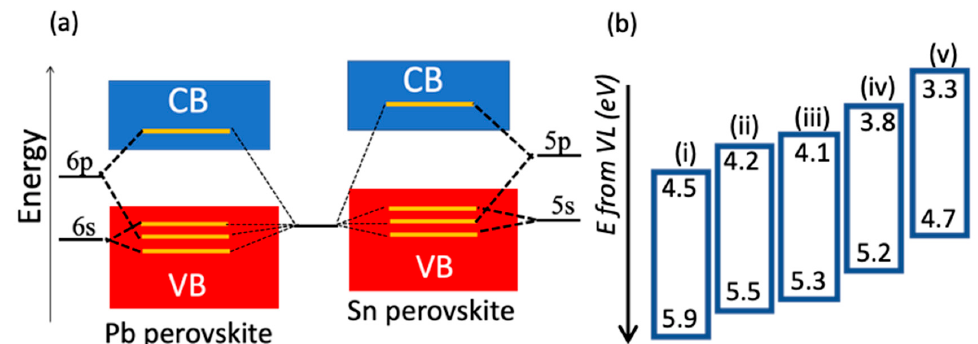
Figure 2. Energy of Sn perovskite bands compared to Pb perovskite and often observed discrepancy of measured and reported values of Sn perovskites’ properties, manifested in the bandgap, and the position of valence and conduction bands (VB and CB, respectively) with respect to vacuum level (VL). ( a ) Higher energy band of Sn-perovskites, and ( b ) Discrepancy of energy reported values of FASnI 3 ( i ) [53], ( ii ) [54], ( iii ) [55], ( iv ) [56], and ( v ) [57].